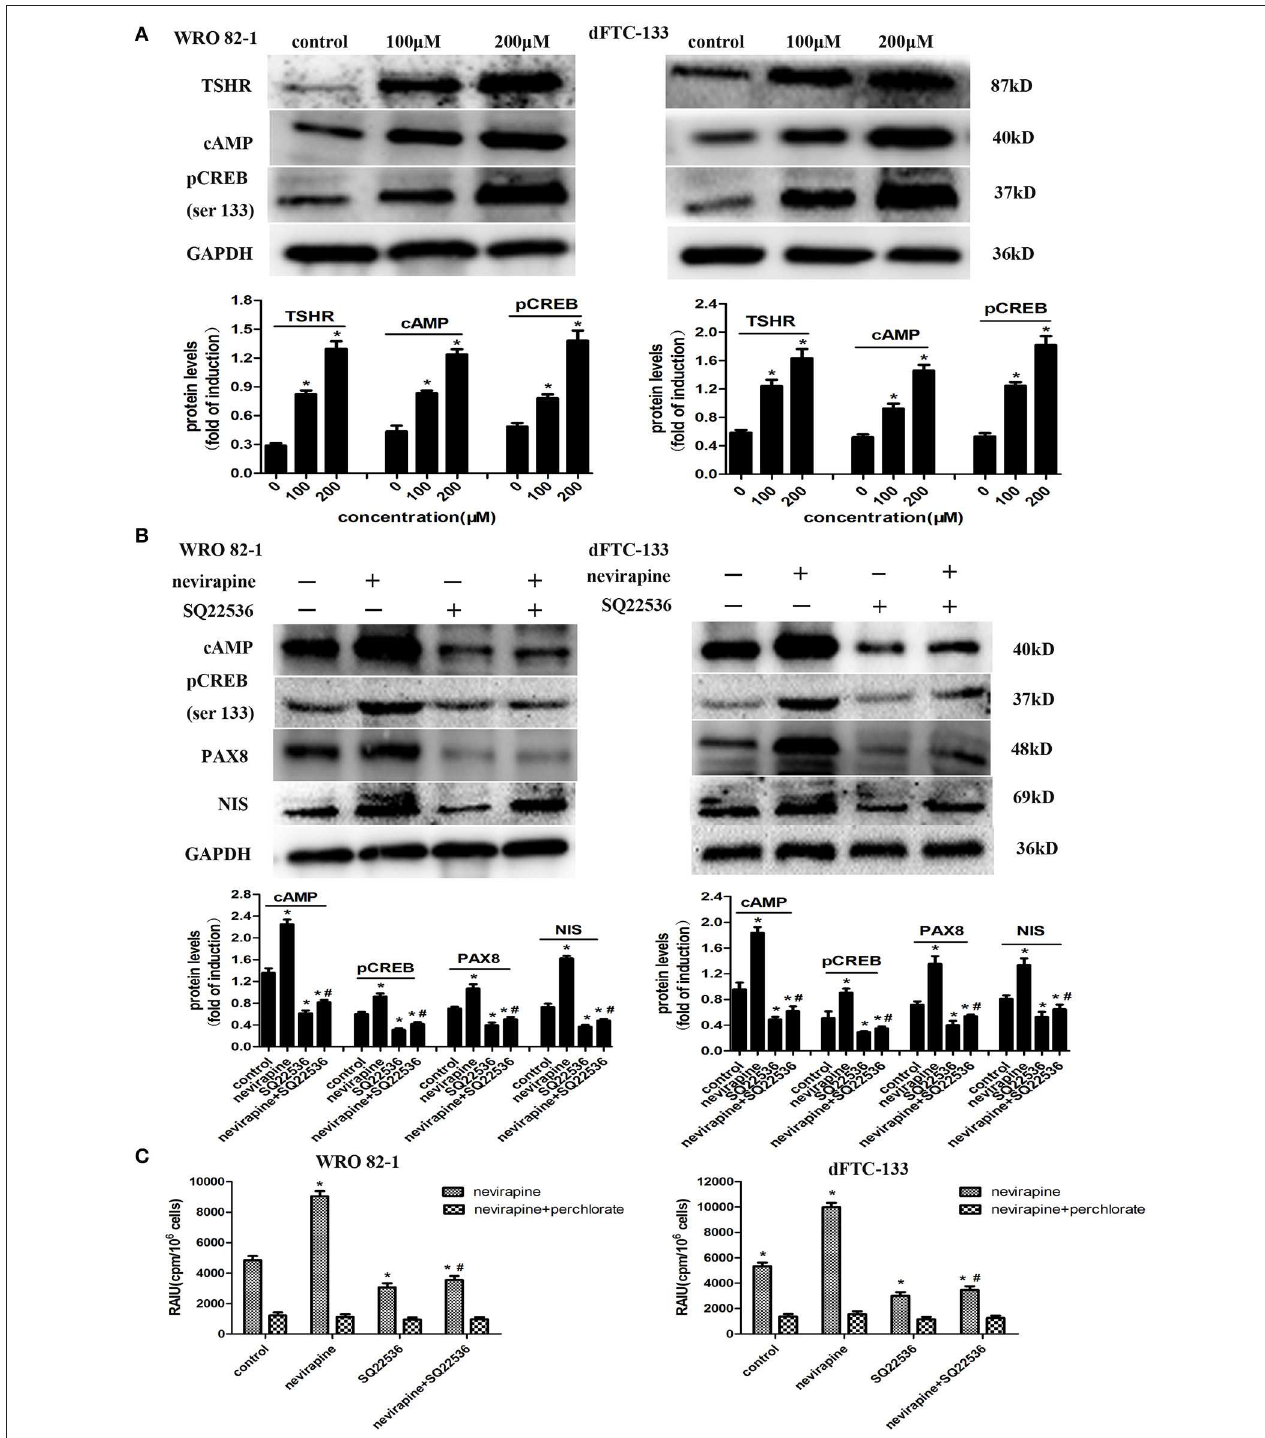
FIGURE 5 | Nevirapine increased NIS-mediated radioiodide uptake by activation of TSHR/cAMP/CREB/PAX8 signaling pathway in dedifferentiated thyroid cancer cells. (A) The expressions of TSHR, cAMP, and pCREB (ser 133) in WRO 82-1 and dFTC133 cells after 72h of nevirapine treatment were determined by western blot with quantitative analysis. GAPDH was used as the loading control. (B) The expressions of cAMP, pCREB, PAX8, and NIS in WRO 82-1 and dFTC-133 cells treated with or without 200 µ M nevirapine and SQ22536 for 72h were determined by western blot and analyzed quantitatively. (C) RAIU in WRO 82-1 and dFTC-133 cells was determined in treated cells with 200 µ M nevirapine for 72h with or without sodium perchlorate. The sodium perchlorate was used as a selective inhibitor for NIS-mediated iodide uptake. * P < 0.05 vs. control, # P < 0.05 vs. relevant group treated by nevirapine only.